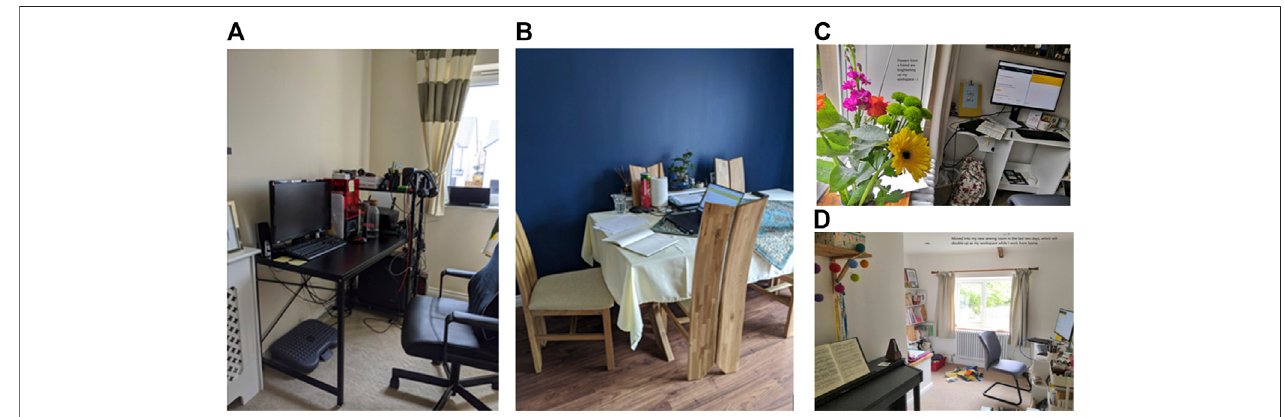
FIGURE 6 | Positive engagement with the